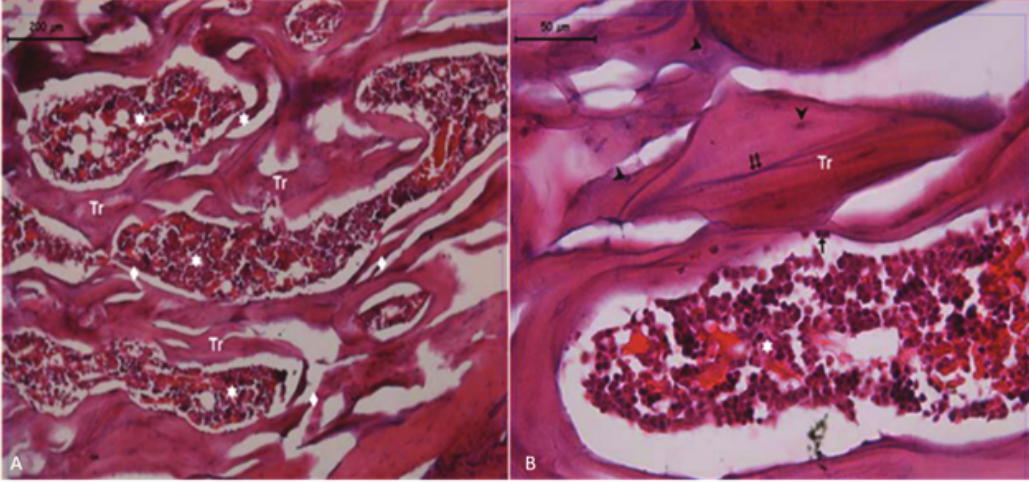
Figure 3: Microscopic view of the femoral neck in the diabetic group treated with insulin. Tr: trabeculae; *Bone marrow tissue; ◊ Irregular bone trabeculae. Arrowhead: Osteocyte; Arrow: Osteoblast (Hematoxylin– Eozin).